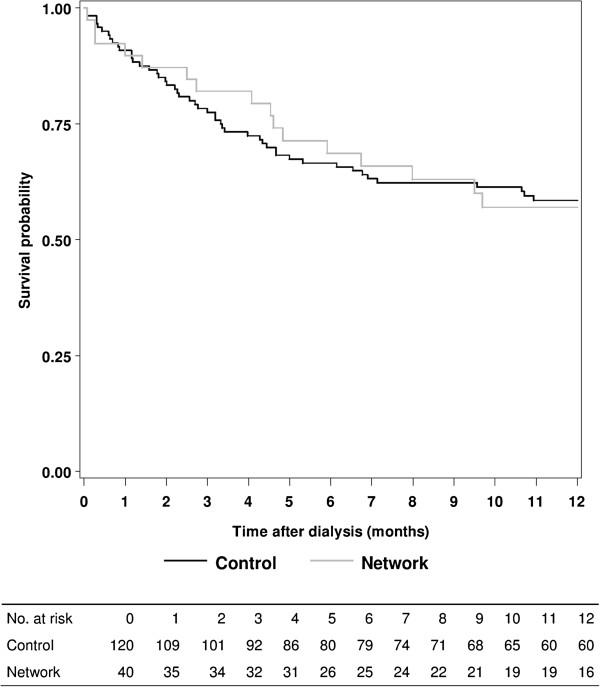
Event-free survival (cardiovascular events or cardiovascular death) using Kaplan-Meier estimates on 160 patients (log-rank p-value=0.9706).